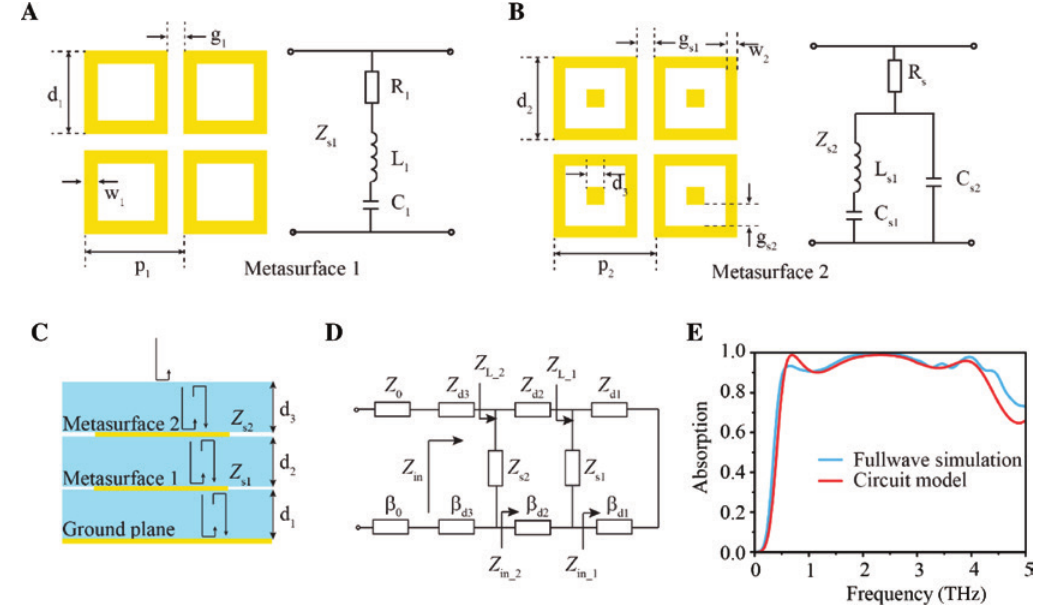
Figure 3: Theoretical simulations of the broadband THz absorber. Geometric parameters and the corresponding general equivalent circuit theory for metasurface 1 (A) and metasurface 2 (B). (C) Schematic of the transmission line model for broadband THz absorption. (D) Equivalent circuit model of the structure with the dual metasurface based